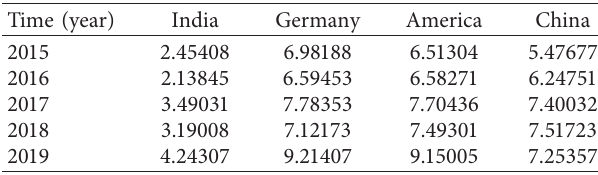
Table 4: Educational health evaluation form.